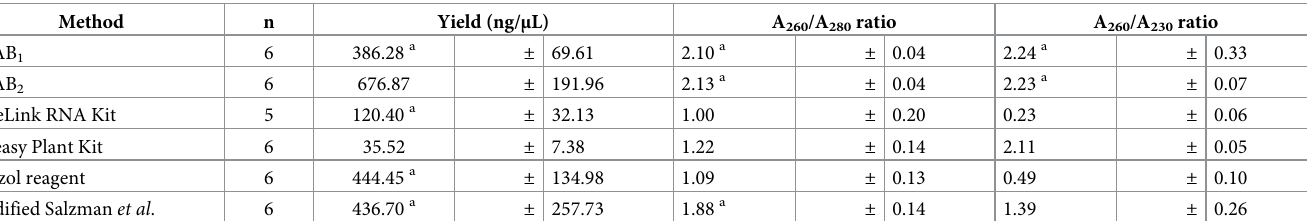
Table 1. Analysis of RNA yield and purity for different methods.